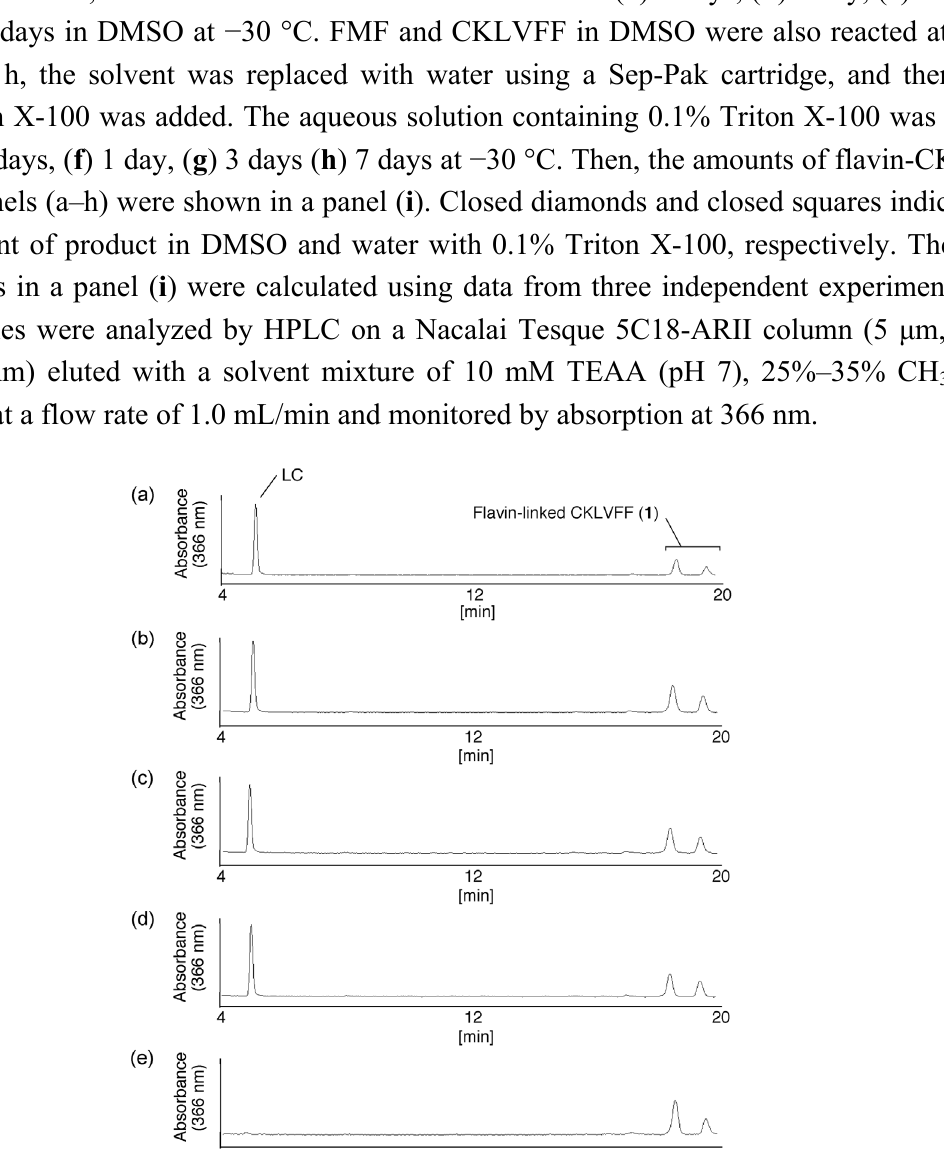
Figure 8. Stability of flavin-CKLVFF ( 1 ). FMF and CKLVFF in DMSO were reacted at 65 °C for 1 h, and then the reaction solution was left for ( a ) 0 days, ( b ) 1 day, ( c ) 3 days or ( d ) 7 days in DMSO at − 30 °C. FMF and CKLVFF in DMSO were also reacted at 65 °C for 1 h, the solvent was replaced with water using a Sep-Pak cartridge, and then 0.1% Triton X-100 was added. The aqueous solution containing 0.1% Triton X-100 was left for ( e ) 0 days, ( f ) 1 day, ( g ) 3 days ( h ) 7 days at − 30 °C. Then, the amounts of flavin-CKLVFF in panels (a–h) were shown in a panel ( i ). Closed diamonds and closed squares indicate the